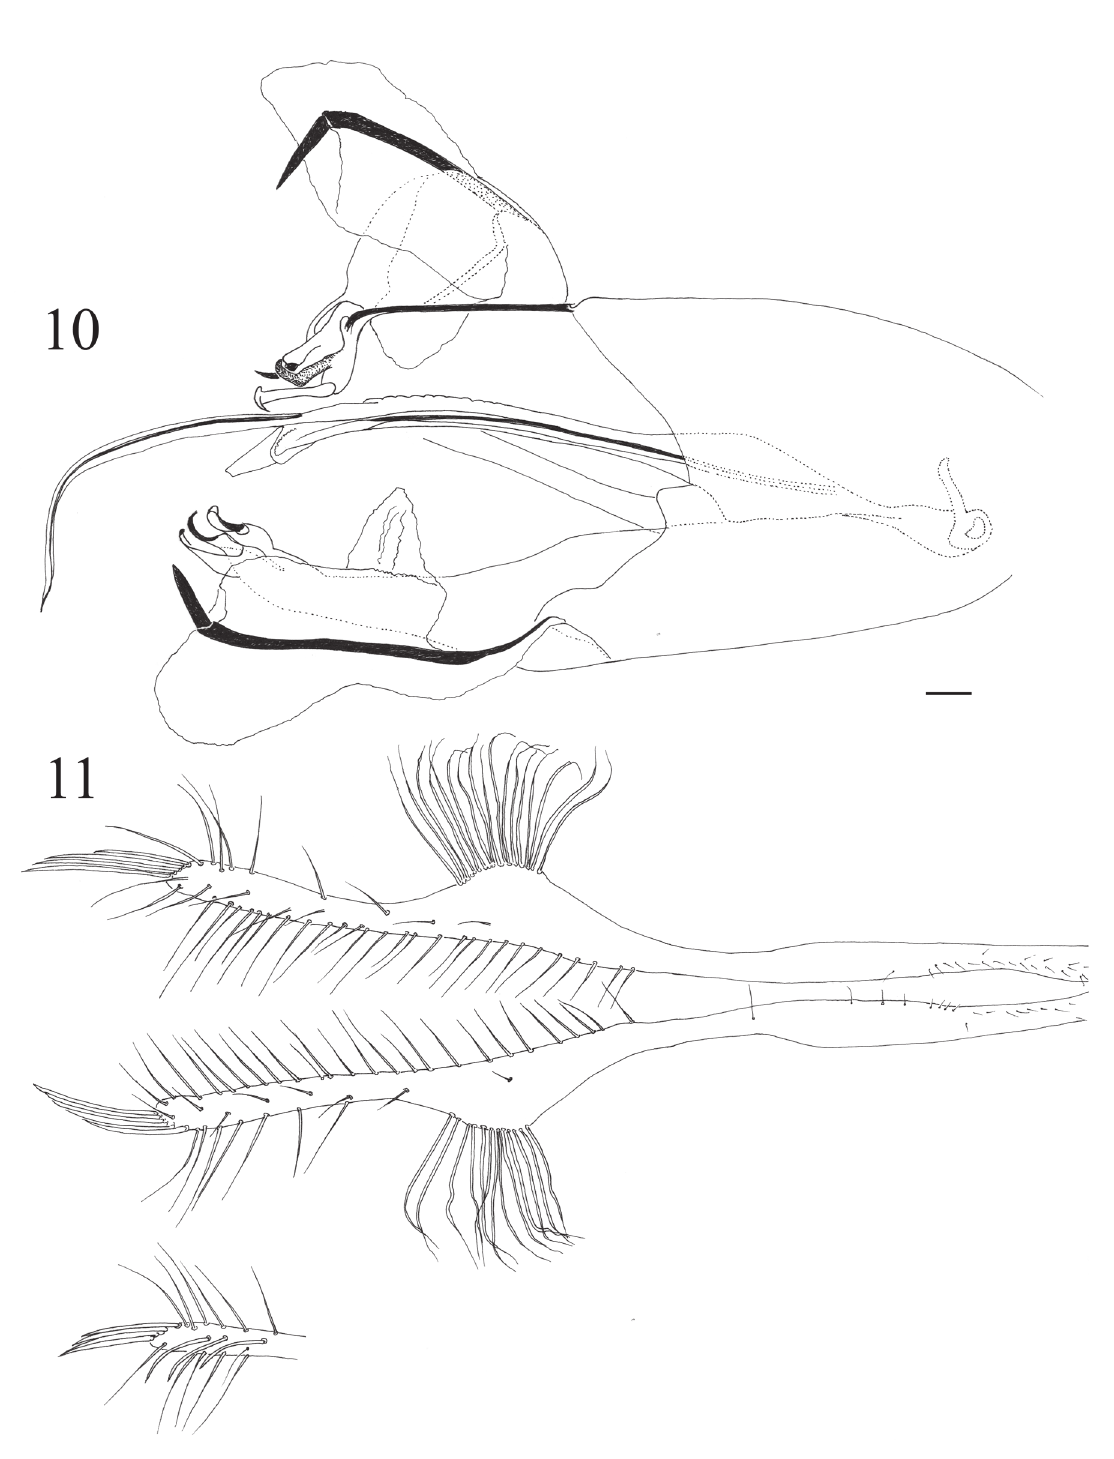
Figs 10–11. Thinophilus langkawensis sp. nov., ♂, terminalia. 10 . Genital capsule and surstyli, ventral view. 11 . Detail of apex of cerci, dorsal